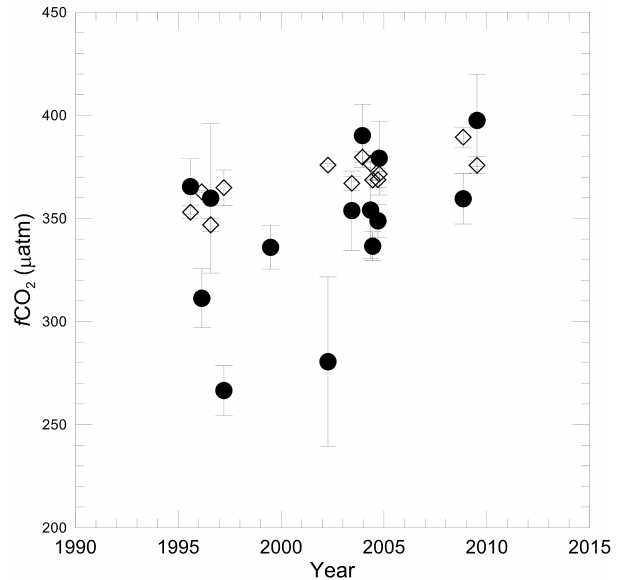
Fig. 2. The secular variations in f CO sea (open diamonds) in the Ulleung Basin, East/Japan Sea, from 1995 to 2009. Error bars represent one standard deviation from the mean value.